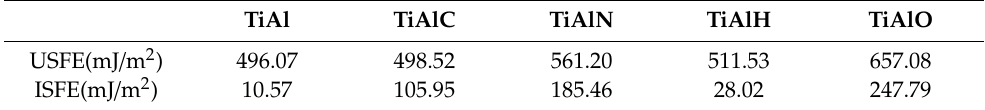
Figure 5. (Color on line.) USFE and ISFE for twin γ-TiAl for slip system (111)/ [112(cid:3364)]. Table 3. Unstable stacking fault energy (USFE) and intrinsic stacking fault energy (ISFE) of twin model. TiAl